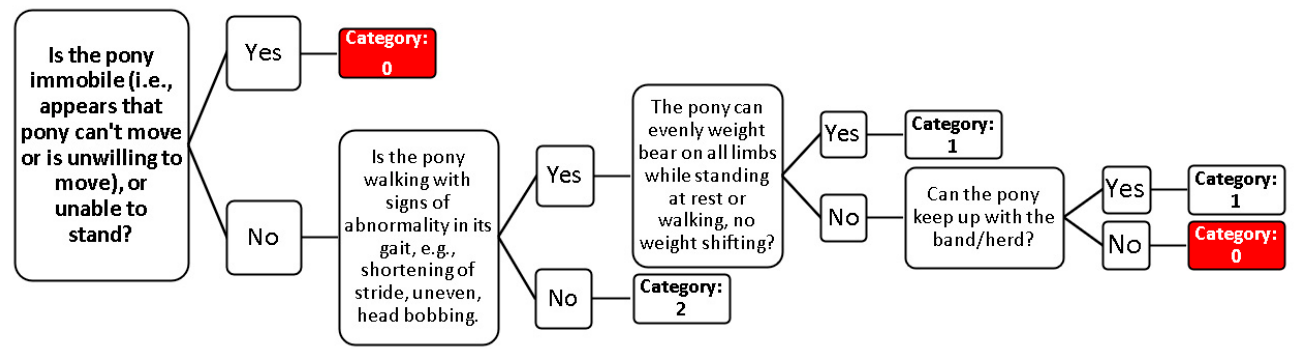
Figure 2. Mobility decision tree from the Carneddau Mountain pony welfare indicators template.